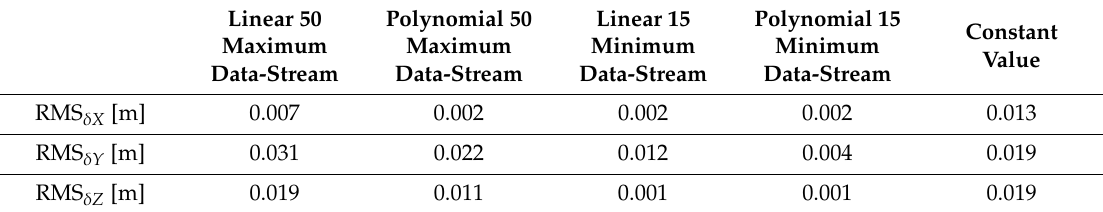
Table 2. The RMS values of the time series of geocentric corrections between each IODE change value (GPS